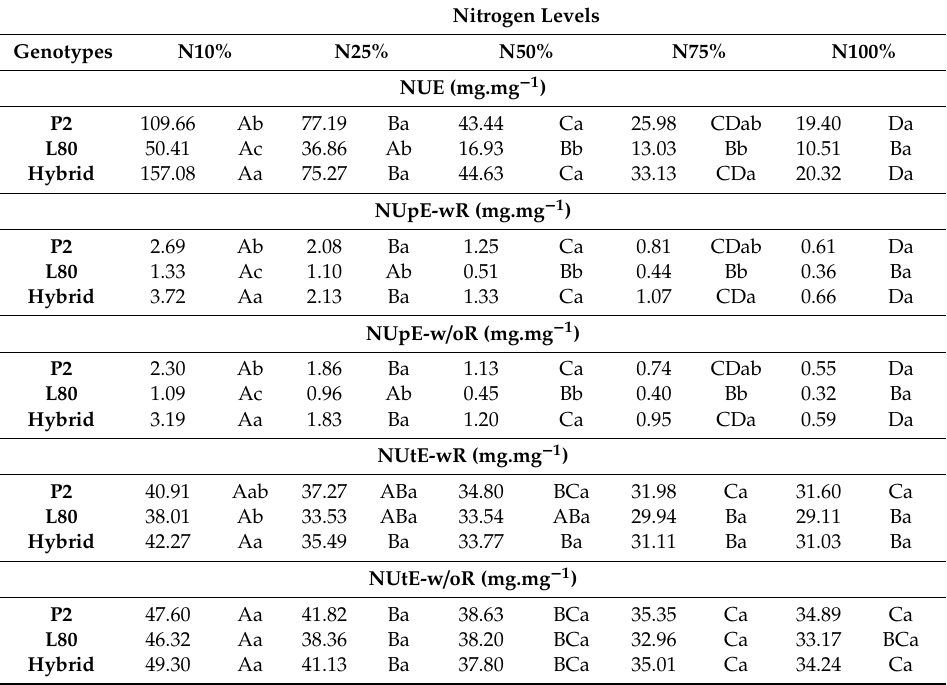
Table 5. Mean values of popcorn genotypes for N use e ffi ciency (NUE) and its components of uptake and utilization under five di ff erent N levels at the V6